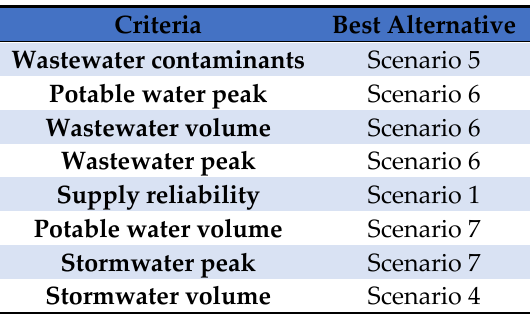
Table 3. Best alternatives based on various criteria.